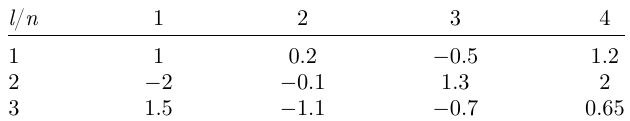
Table 2. Amplitudes A ( n , l ) for the different patterns applied in Equation (17).